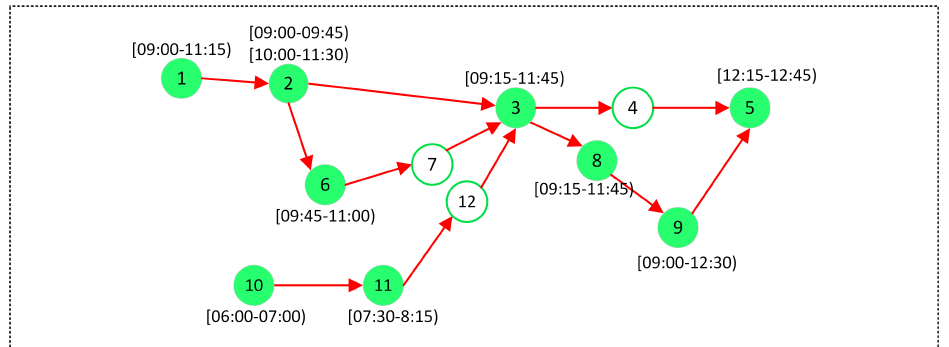
Figure 4. Simplified TNGraph where nodes with attribute ec = High have associated intervals. Every node represents a river segment and sensor nodes are filled in